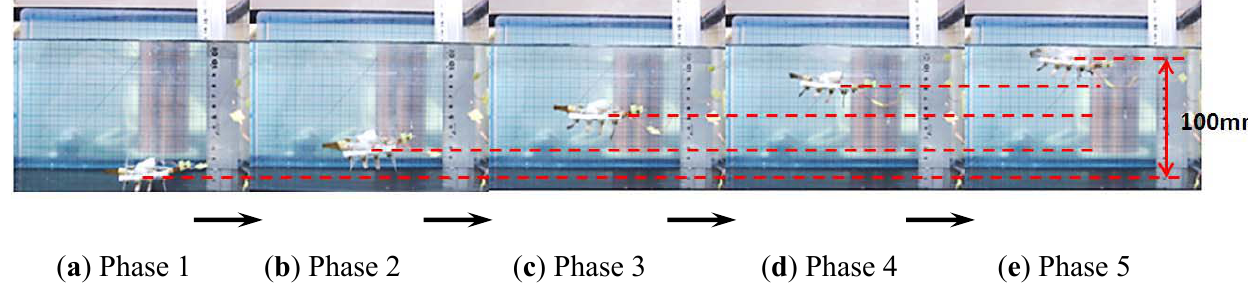
Figure 26. Experimental floating